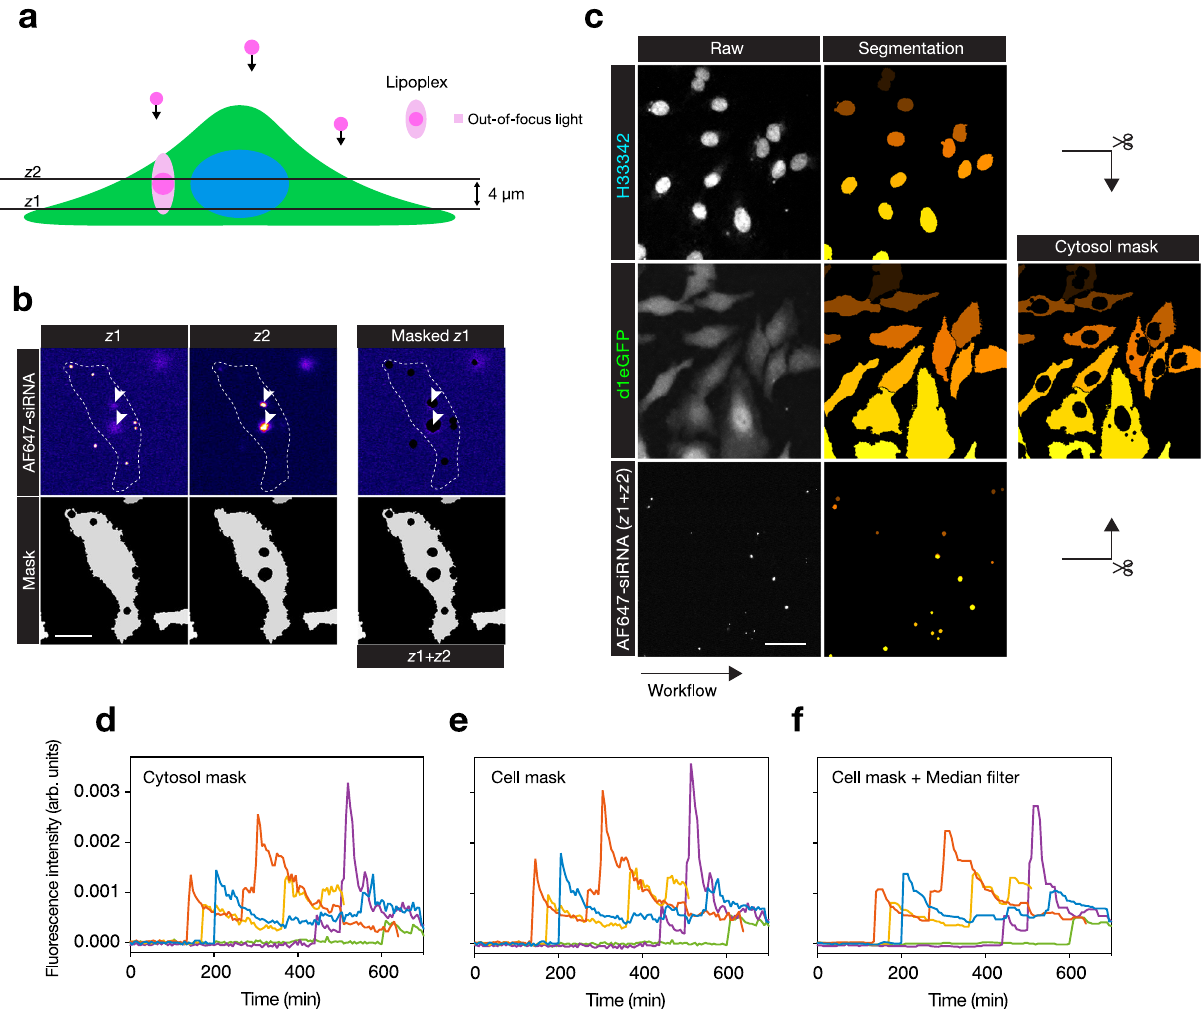
Fig. 2 | Quantifying cytosolic siRNA signals in single cells. a Two z -planes are acquired during live-cell microscopy. In-focus lipoplexes captured in the upper plane ( z 2) are used to mask out-of-focus light contaminating the lower z -plane ( z 1) used for cytosolic siRNA detection. b Cell (in z 1) masked from bright lipoplexes, including out-of-focus light (in-focus in z 2). The outline indicates cell and arrows indicate lipoplex fl uorescence detected in both z -planes. The scale bar is 20 µ m. c The fi nal cytosol image mask used for siRNA detection after segmentation and